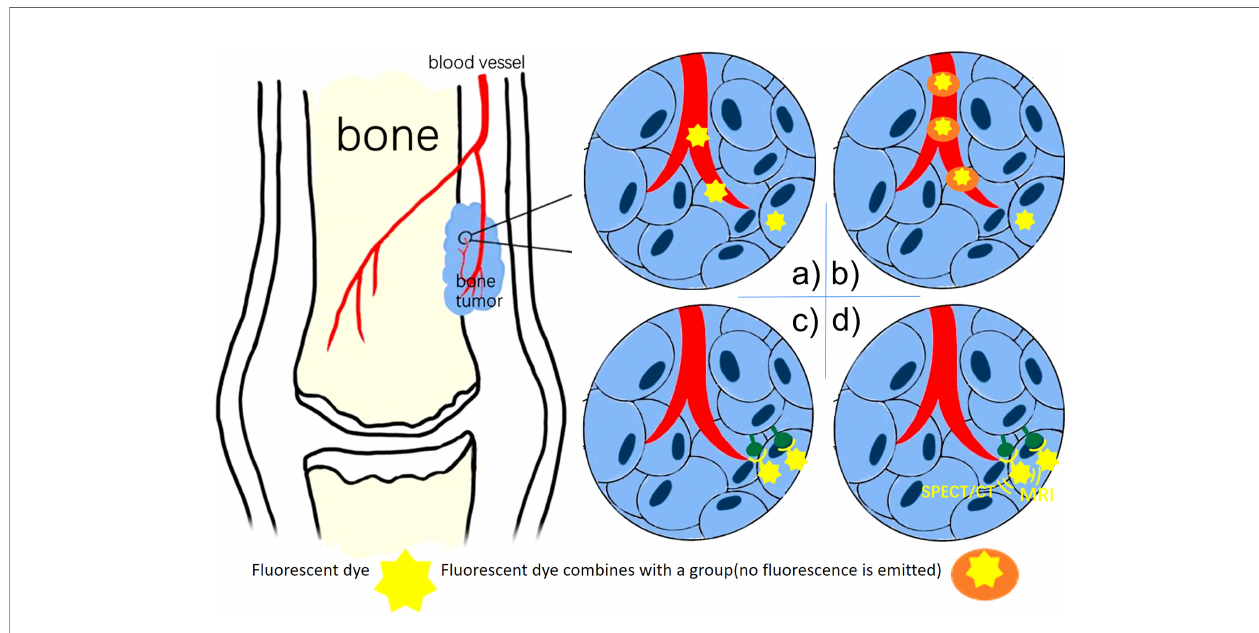
FIGURE 1 | (A) Non-Speci fi c Fluorescent Probes (ICG): the fl uorescent dye remains in areas where the vasculature is highly disordered. (B) Activatable Fluorescence Probes: the dye fl uorescence only when the group breaks down under tumor circumstances. (C) Speci fi c fl uorescent Probes: the fl uorescent dye combines antibodies bind to biomarkers. (D) Multimodality Fluorescence Imaging Probes: the fl uorescent dye used for both NIR imaging and SPECT/CT,